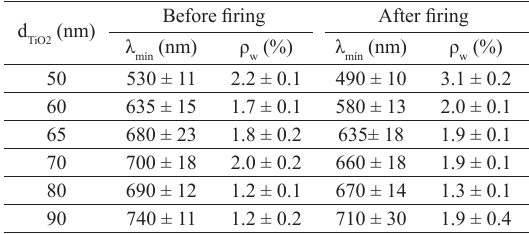
Table 1. The wavelength of the minimum spectral reflectance and weighted reflectance for textured silicon wafers coated with TiO films deposited by e-beam evaporation. d measured after the e-beam evaporation. d TiO2